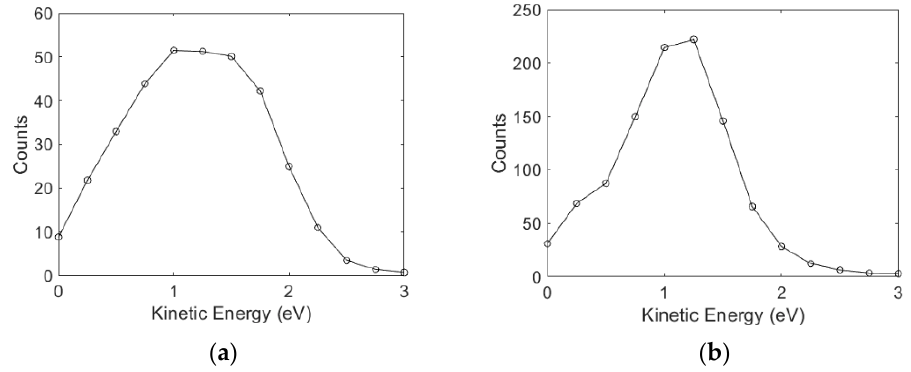
Figure 4. Kinetic energy distribution of the H − ions obtained from ( a ) aniline at 4.7 eV and ( b ) benzylamine at 5.5 eV electron